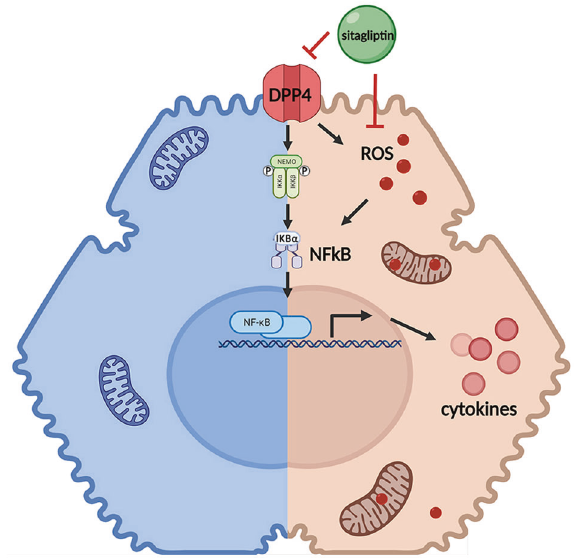
Fig. 6 Schematic of the mechanism of sitagliptin in improving liver in fl ammation. Speci fi cally inhibiting the activity of DPP4 in hepatocytes by sitagliptin contributes to decreased activation of NF κ B pathway and oxidative stress, as well as cell apoptosis under diabetic conditions. The ROS cleaning function of sitagliptin promotes the deactivation of NF κ B